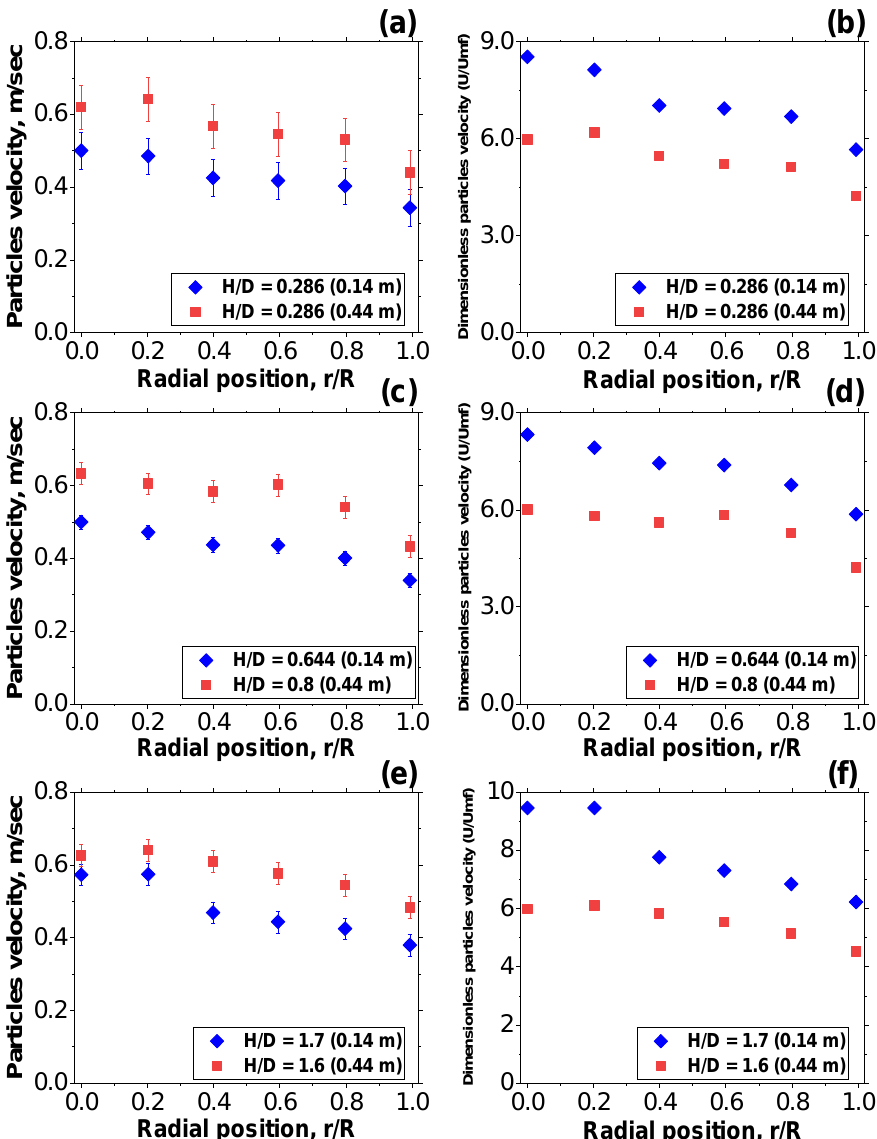
Figure 12. Up Flowing Radial Particles Velocity ( a , c , e ) and Dimensionless Particles Velocities Profiles ( b , d , f ) for Case 1 and Case 2 at Different Height above the Distributor where Case 2 are matching dimensionless groups.